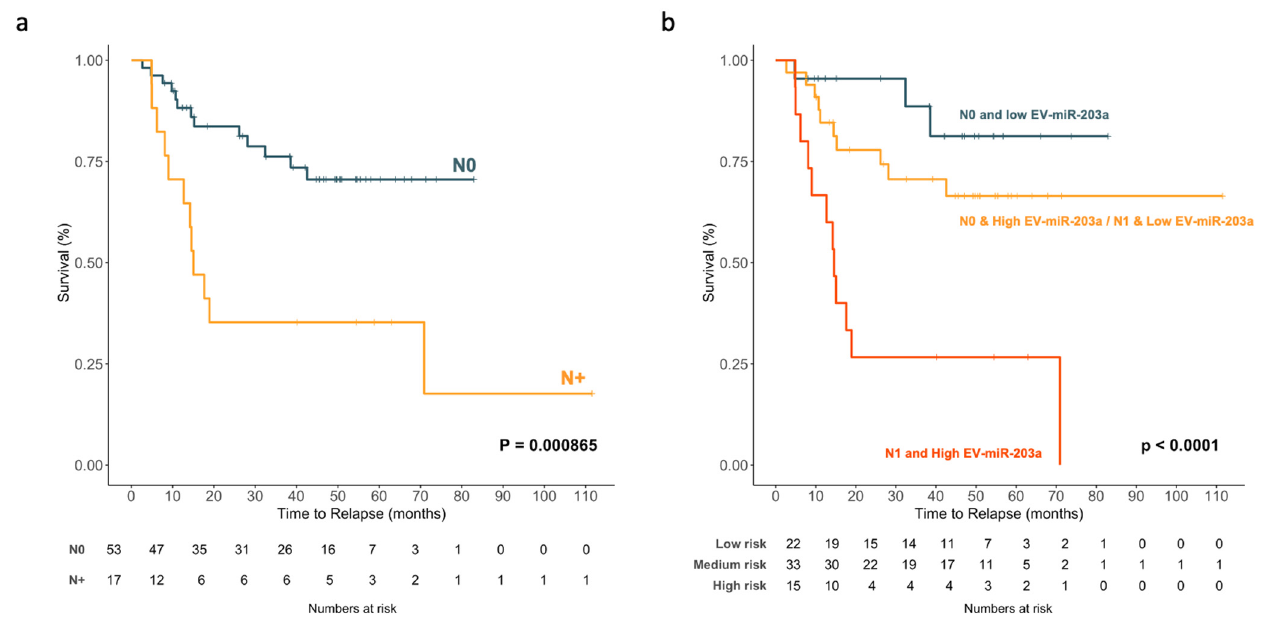
Figure 9. Kaplan–Meier survival analysis for TTR of ( a ) N0 vs. N+ and ( b ) the combination of N and TDV EV-miR-203a-3p levels among patients with NSCLC.